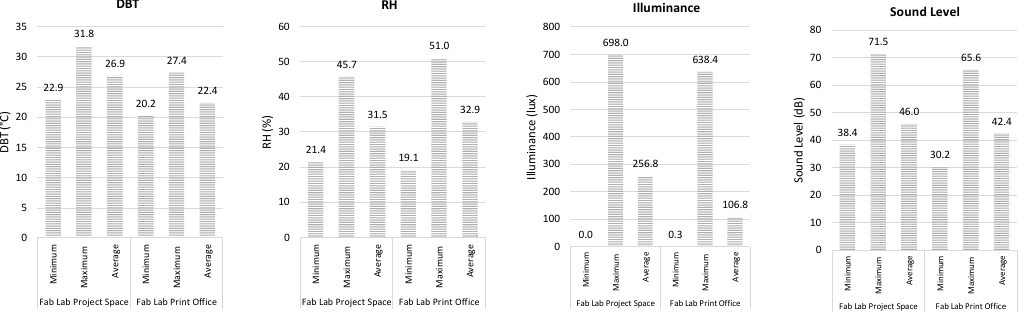
Figure 13. Minimum, maximum and average values recorded in Fabrication Lab (Source: IoT sensors during April 2019).